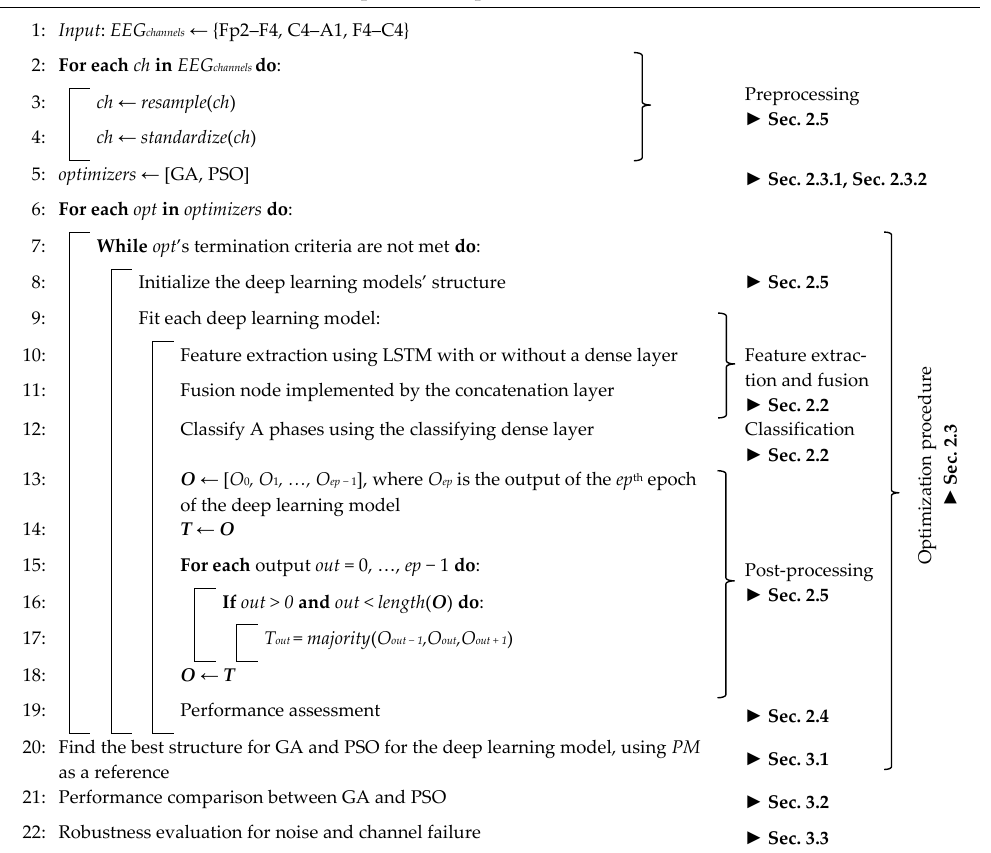
Algorithm 1 Pseudocode for the experimental procedure. Algorithm 1. Pseudocode for the experimental procedure.